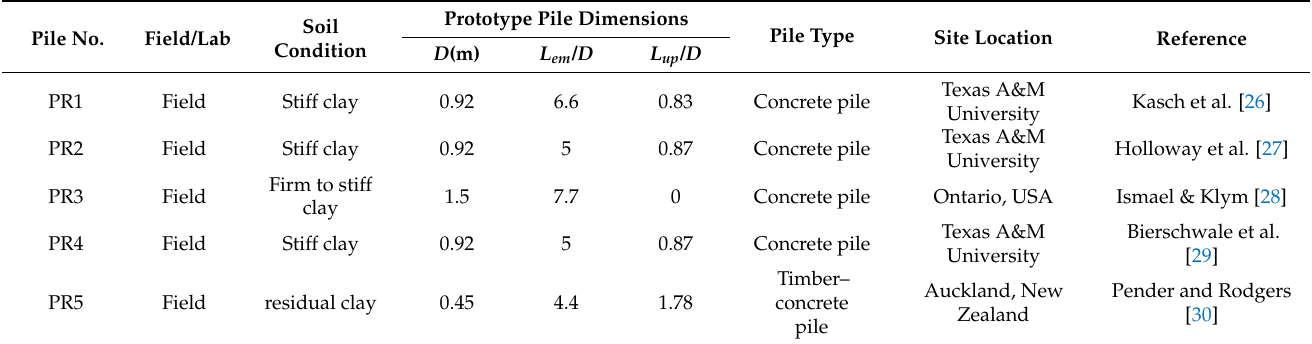
Table 1. Pile tests for determination of rotation point.